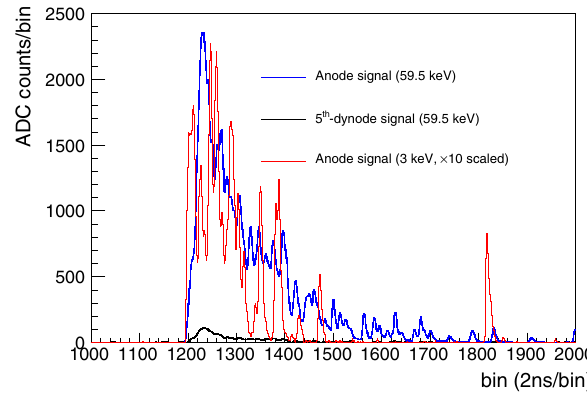
Fig. 17 Crystal-1 raw waveforms from a 59.5keV 241 Am source and 3keV 40 K emission (scaled up by a factor of ten) are overlaid for anode signal comparisons. For high and low gain comparison, the dynode readout of the same 59.5keV signal is also